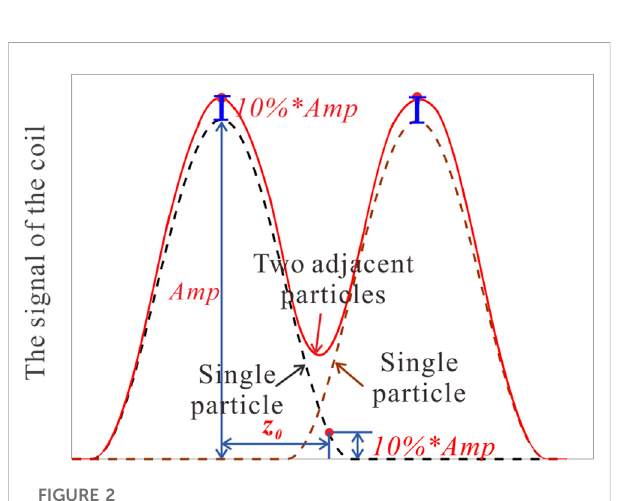
FIGURE 2 Schematic of the output signal induced by two metal particles in a single coil.